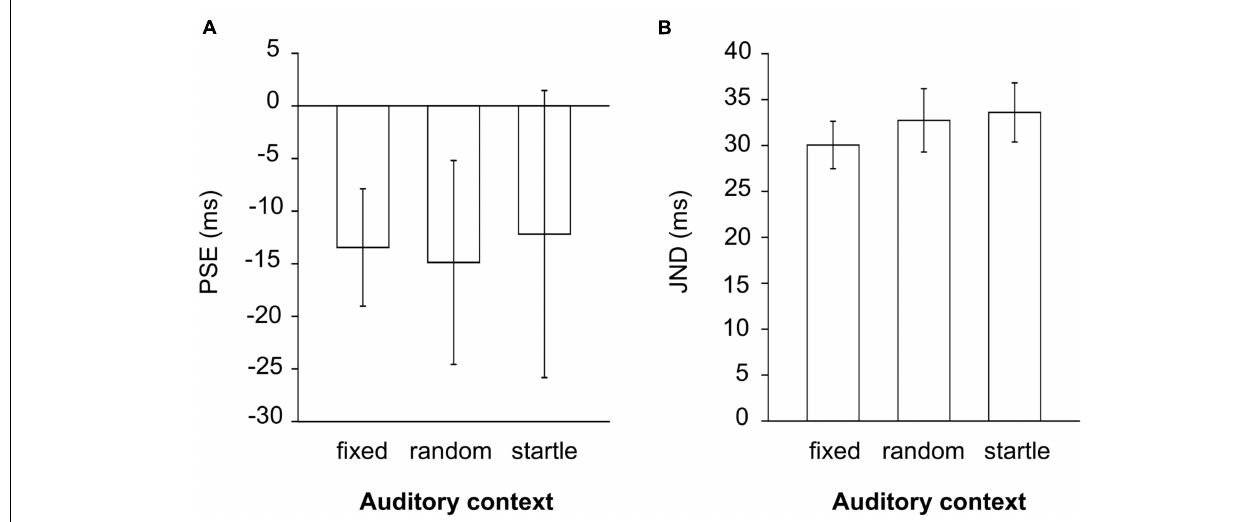
FIGURE 5 | PSE (A) and JND (B) values expressed in milliseconds, measured with regular fixed (fixed), random regular (random), and startle auditory context in Experiment